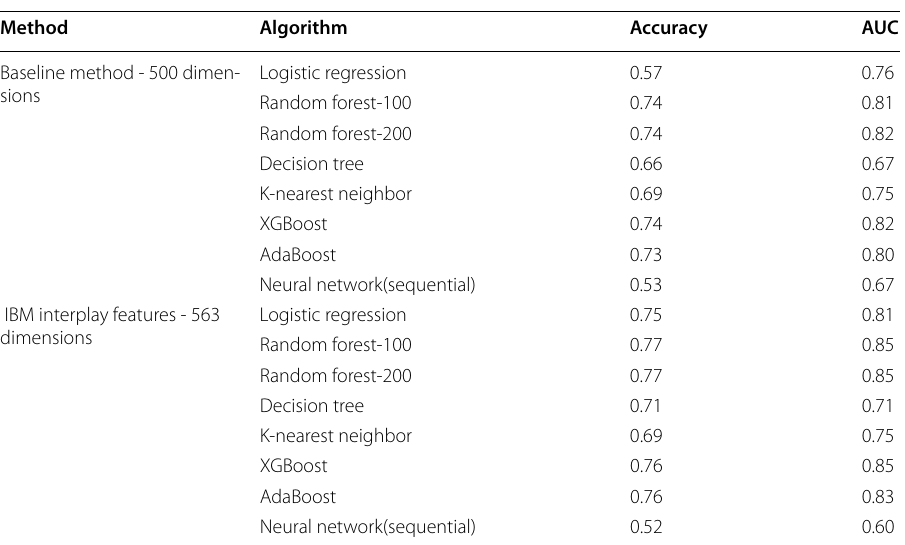
Table 9 Business success prediction results